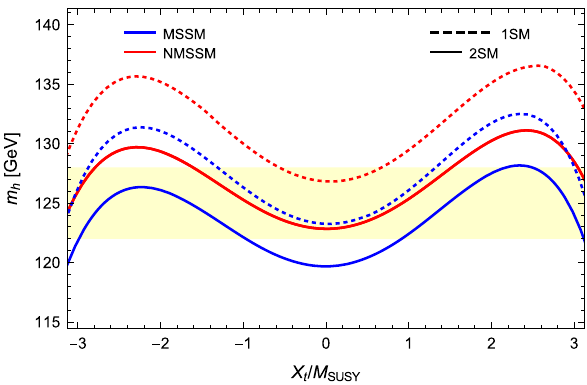
Fig. 12 The Higgs mass in the MSSM and NMSSM as a function of X t / M SUSY using one- and two-scale matching. Here we set μ = M SUSY = 5TeVandusedfortheMSSMtan β = 10, M A = 5TeV.The inputparametersfortheNMSSMwere λ = 0 . 6, κ = 0 . 2, A λ = 10TeV, A κ = − 5 TeV, tan β =